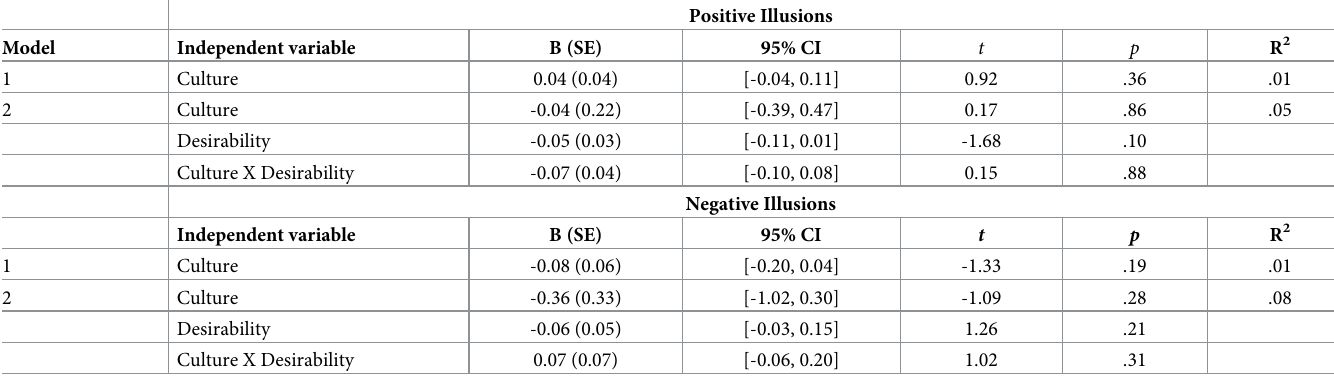
Table 1. Results of the multiple regression analyses in Study